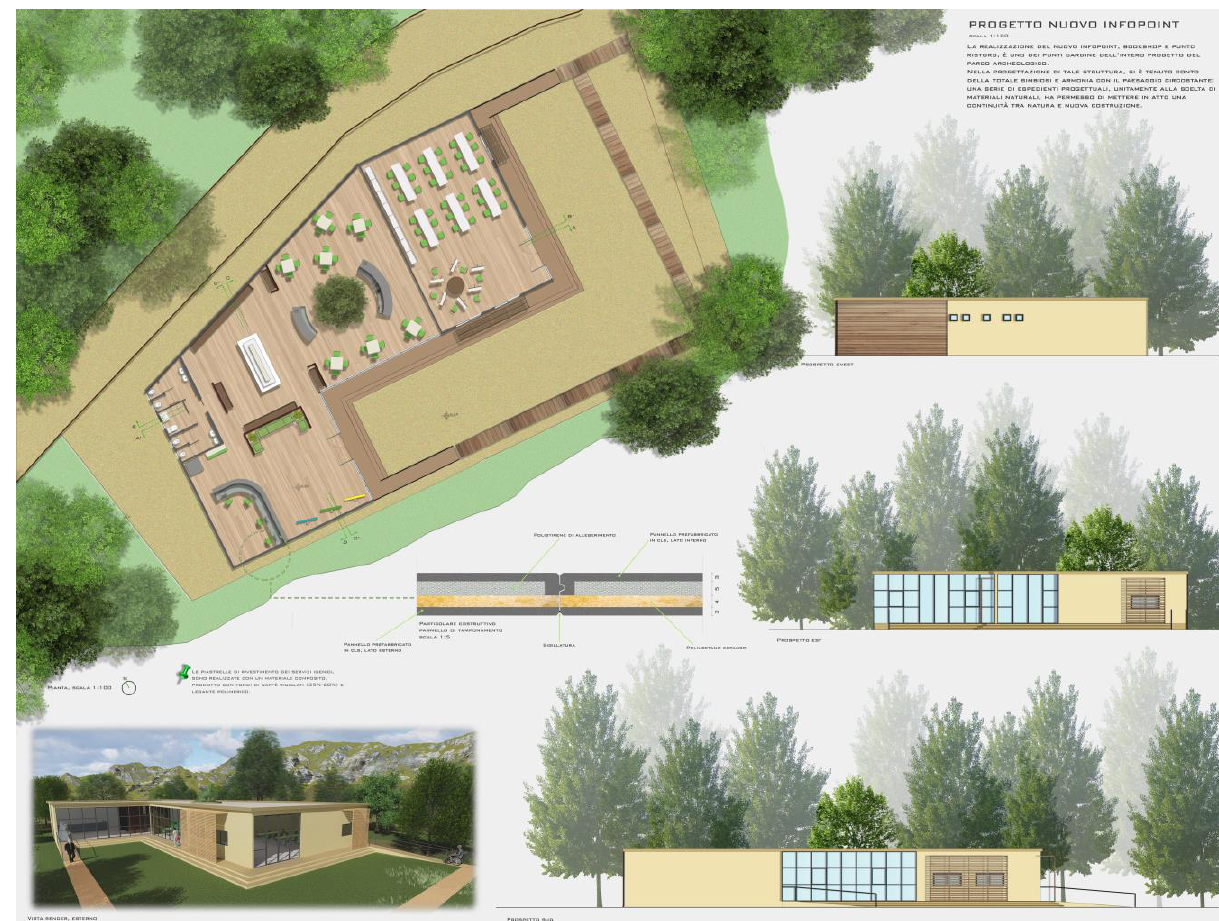
Figure 6. Design of structures with reduced visual impact aimed at hosting services for the